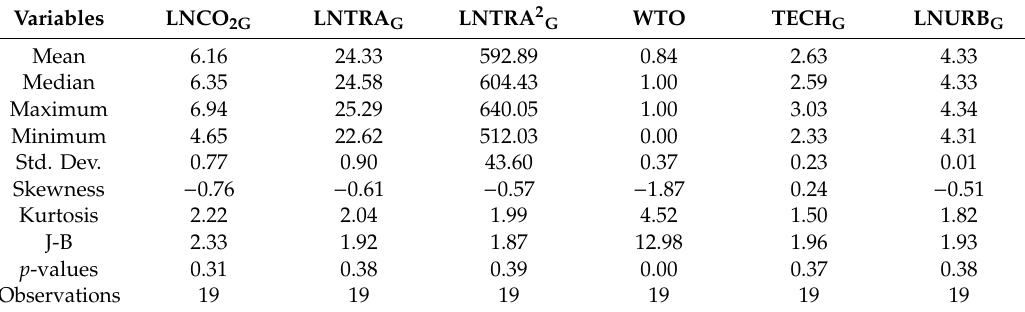
Table 4. Descriptive statistics results for Germany.